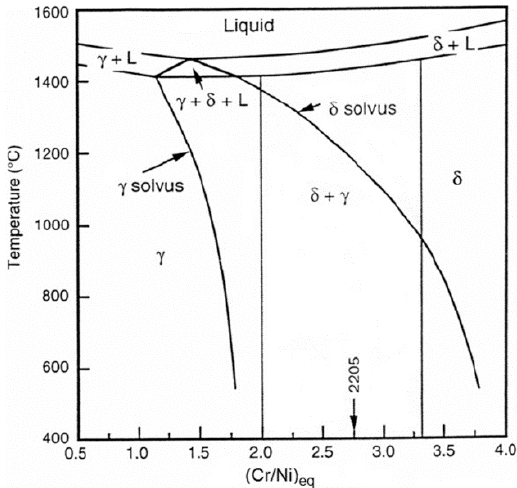
Figure 17. Pseudo-binary diagram based on WRC-1992 equivalent relationships 37